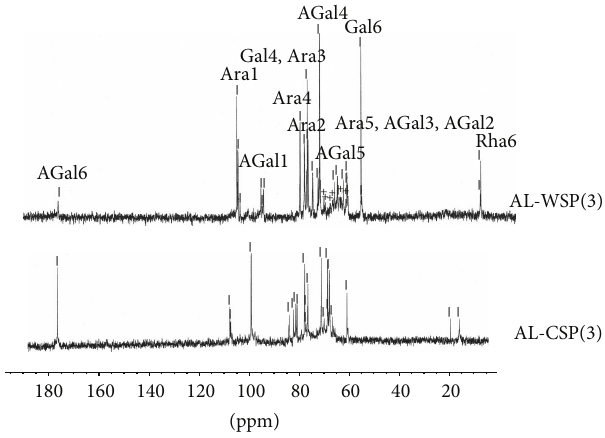
Figure 3: 13 C spectra of water-soluble (AL-WSP3) and chelating- soluble (AL-WSP3)